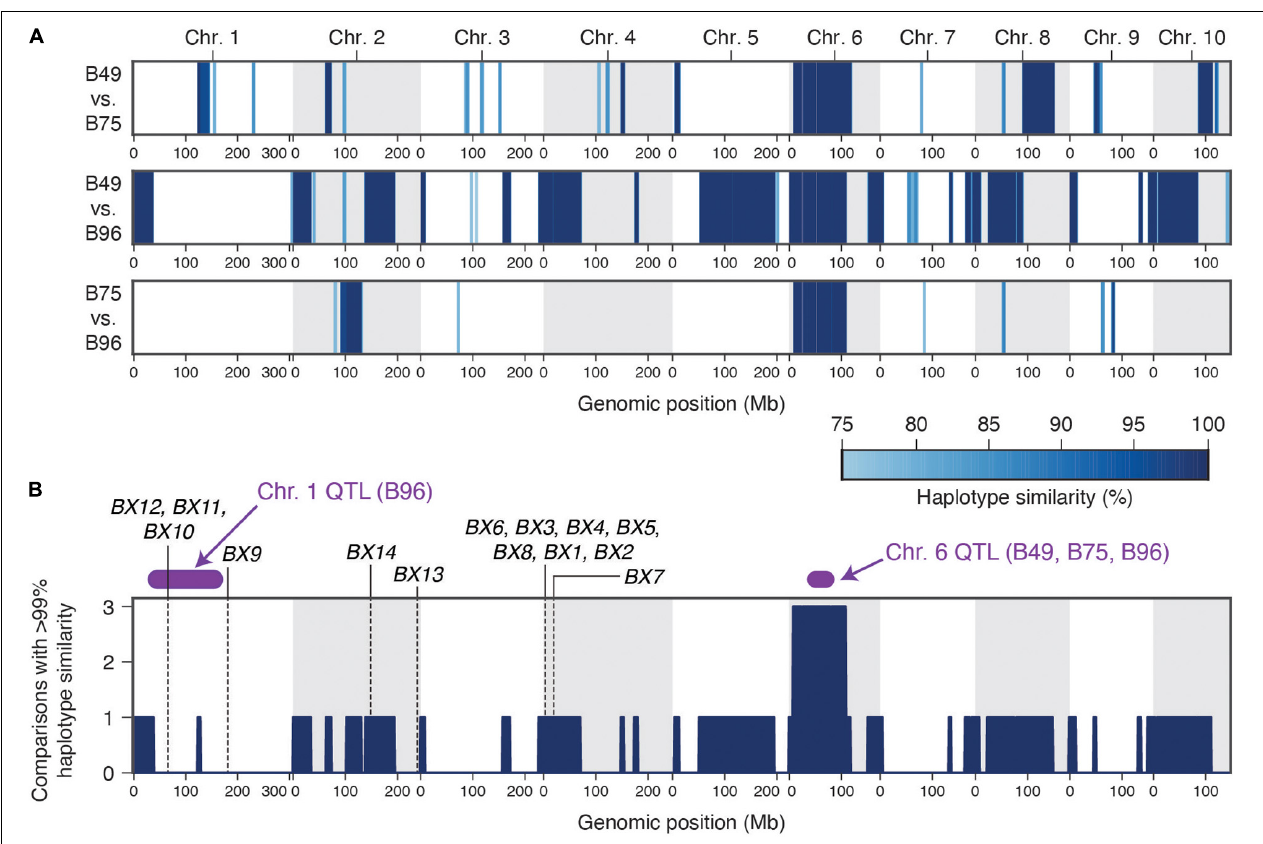
FIGURE 6 | A single haplotype on chromosome 6 associates with high-level resistance to T. urticae in maize lines B49, B75, and B96. (A) Haplotype similarities as assessed with SNP data in sliding window analyses are shown for all pairwise comparisons between B49, B75, and B96. The depth of blue shading indicates the % haplotype similarity (see scale, lower right). (B) Genomic regions for which the identical (or nearly identical) haplotypes are observed in multiple comparisons among the three resistance maize lines (comparisons with > 99% similarity, dark blue). The location of peak genomic intervals for major QTL identified on chromosome 1 (B96) and chromosome 6 (B49, B75, and B96) ( Figure 4 and section “Results”) are in purple as indicated, and the location of known benzoxazinoid biosynthetic genes (or gene clusters) are indicated by vertical dashed lines. In both panels, chromosomes are demarcated by alternating white and gray